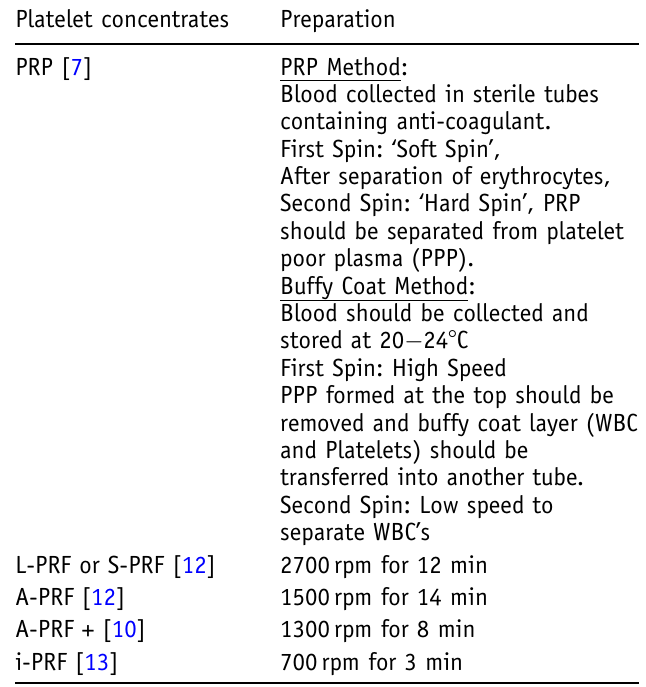
Table II. Methods and protocols for PC